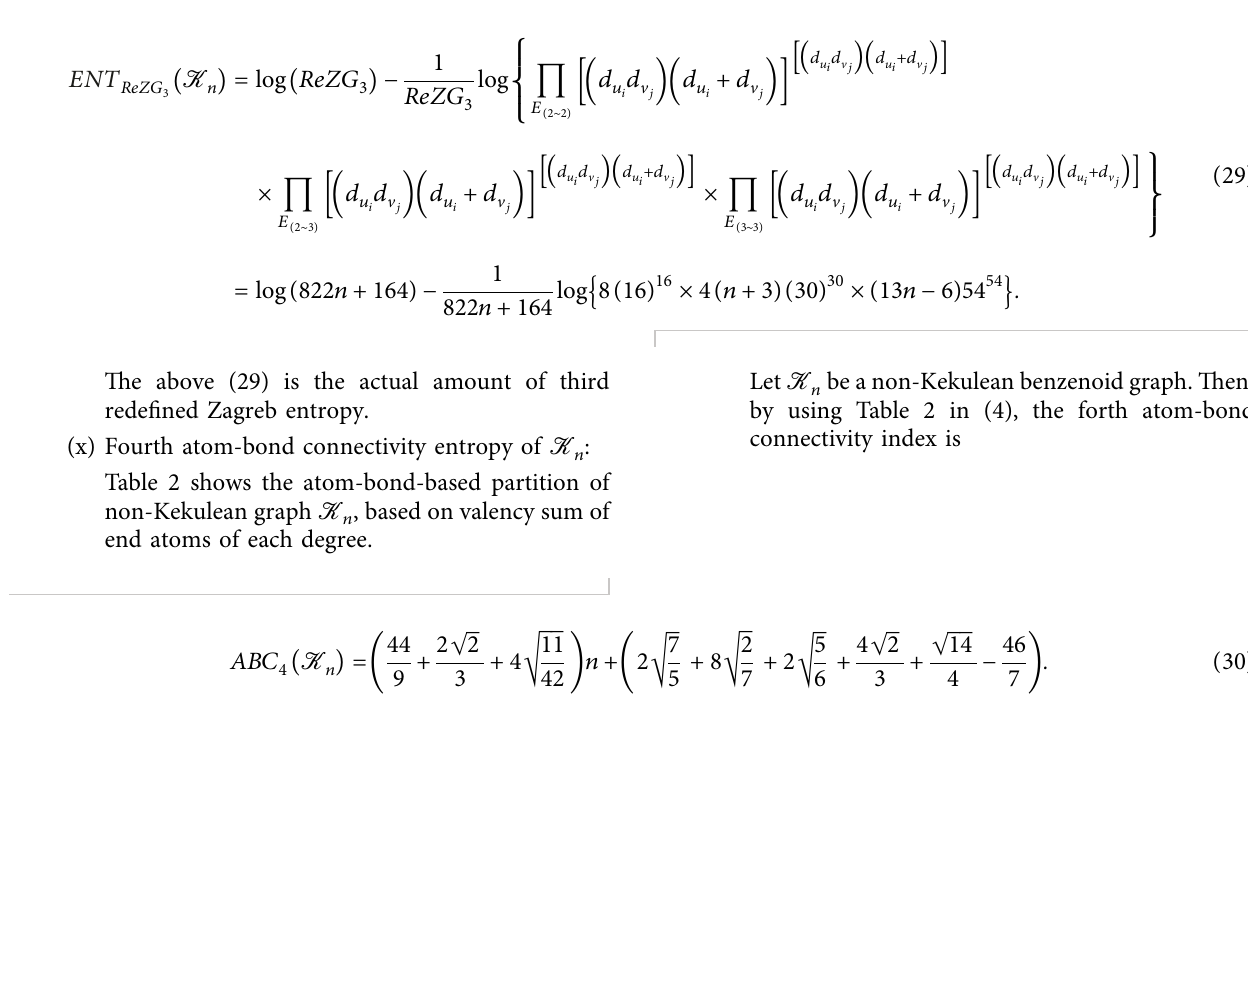
Figure 2: (a) Comparison of ReZG ENTReZG